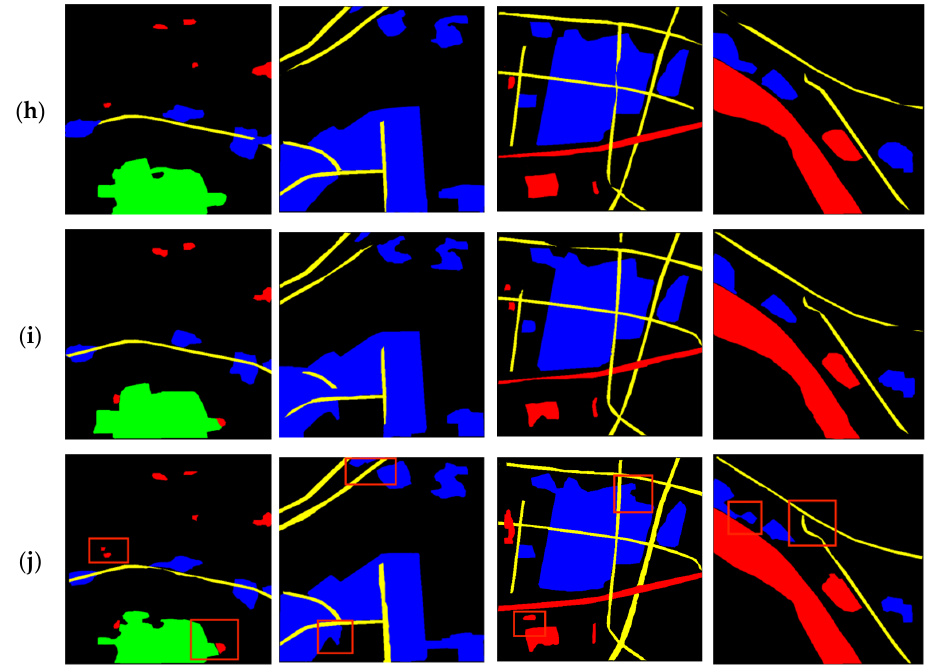
Figure 9. Model prediction results: ( a ) SAR images, ( b ) optical images, ( c ) composite data, ( d ) tag images, ( e ) adaptive threshold results, ( f ) OSTU results, ( g ) FCN network results, ( h ) PSPNet network results, ( i ) Deeplabv3+ network results, ( j ) our method results.